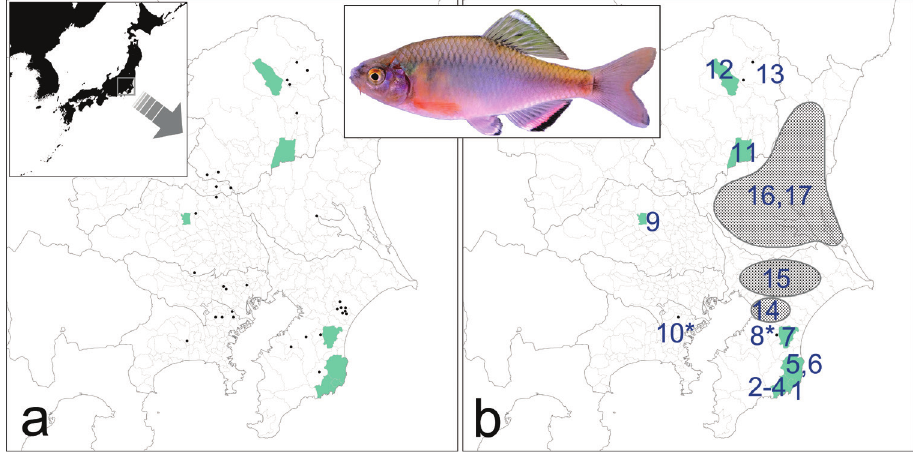
Figure 1. Past ( a ) and present ( b ) geographic distribution of Pseudorhodeus tanago . Dots indicate records of presence of the bitterling. Light blue painted areas contain one to three localities from which specimens of the present report came. Exact places of these localities are kept secret by authorities to protect from poaching. Numbers on map b stand for localities of samples listed in Table 1. Asterisks indicate extinc- tion in the wild and specimens came from ex situ preserved stocks. Habitats #14–17 in hatched areas (exact places are kept secret by authorities) are newly found. Hatched areas thus do not represent exact geographic